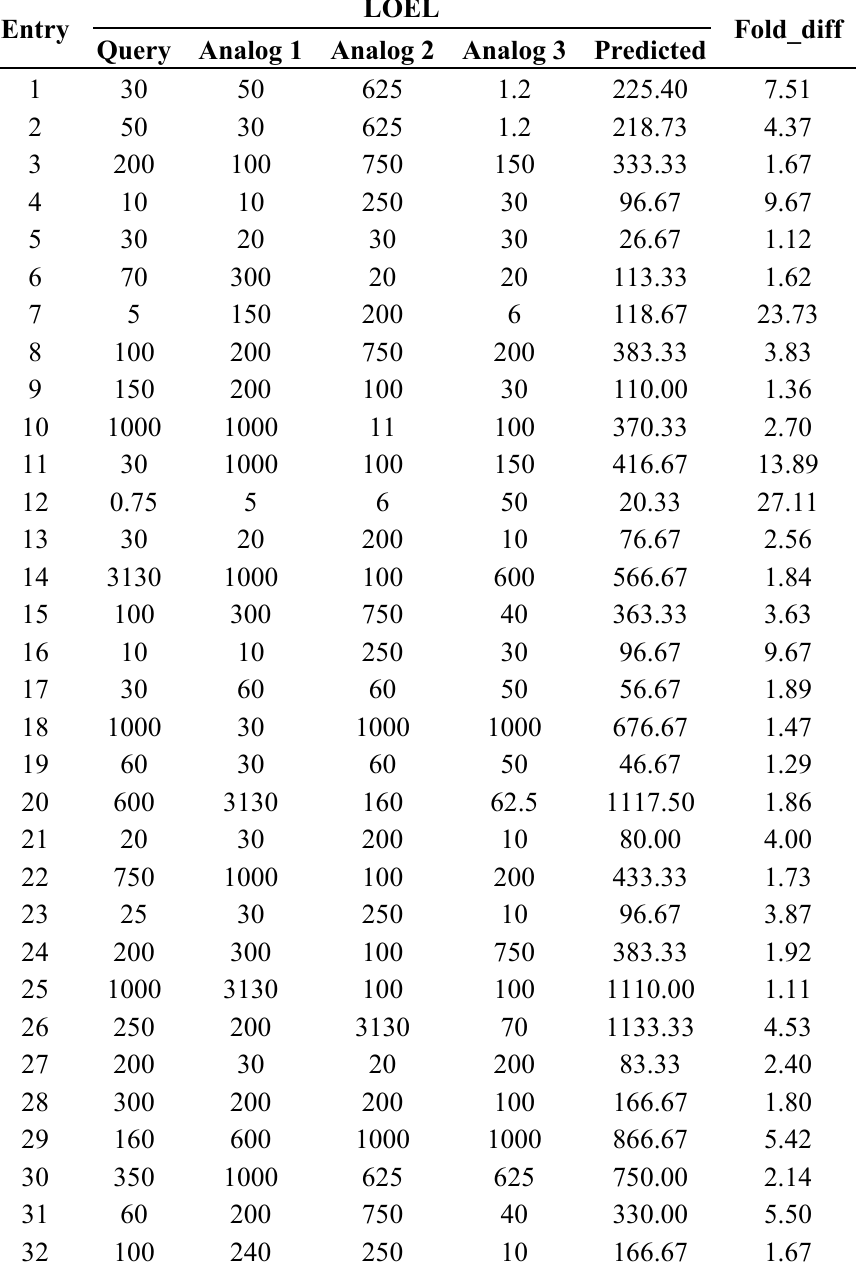
Table 2. Summary of predicted lowest observed effect levels (LOELs) of all training set queries obtained by arithmetic means of LOELs of corresponding k -nearest analogs (3 analogs) from Estate fingerprint based k -NN